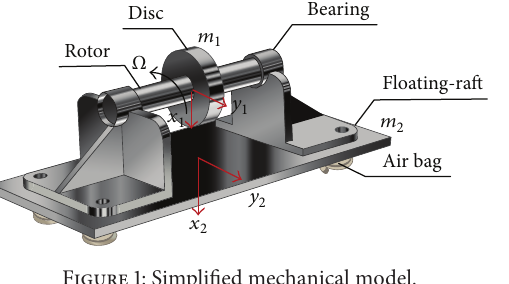
Figure 1: Simplified mechanical model.